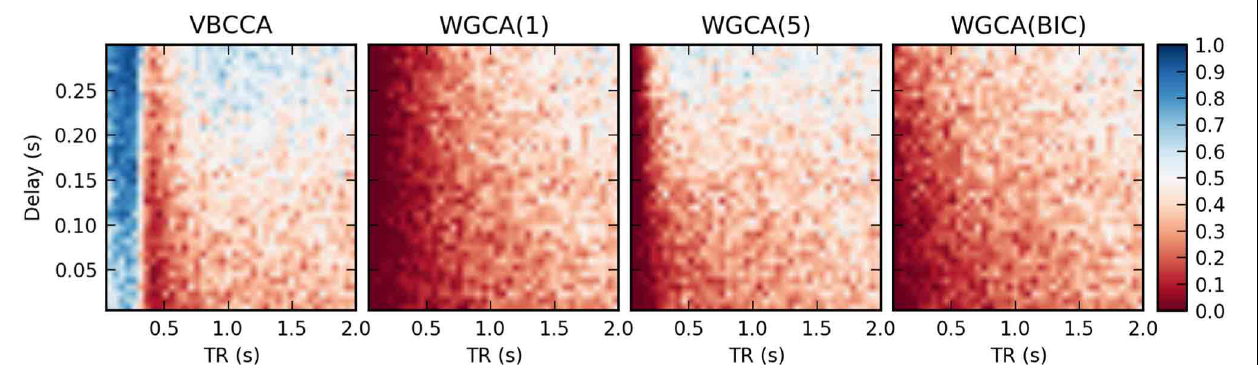
FIGURE 7 | Average d-Accuracy calculated over 50 simulations for a network with two nodes and a single connection for varying neuronal delays (40 steps between 5 and 300ms) and TR values of the fMRI scanner (40 steps between 50ms and 2s). The HRF is held constant for all